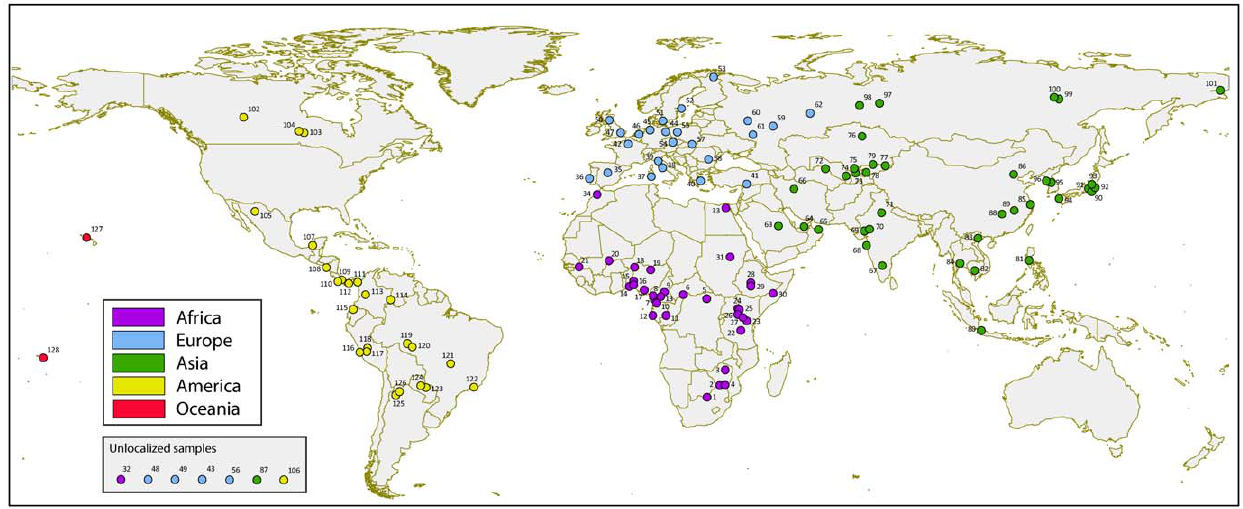
Figure 1. Geographic location of the 128 population samples collected from the literature. Samples are numbered as reported in Table S1 (‘sample ID’). Seven samples could not be localized on the map because of unspecified sampling location (sample 56) or because of divergence between sampling location and region of origin (samples 32, 43, 48, 49, 87, and 106); these samples are displayed in a box beneath the caption.